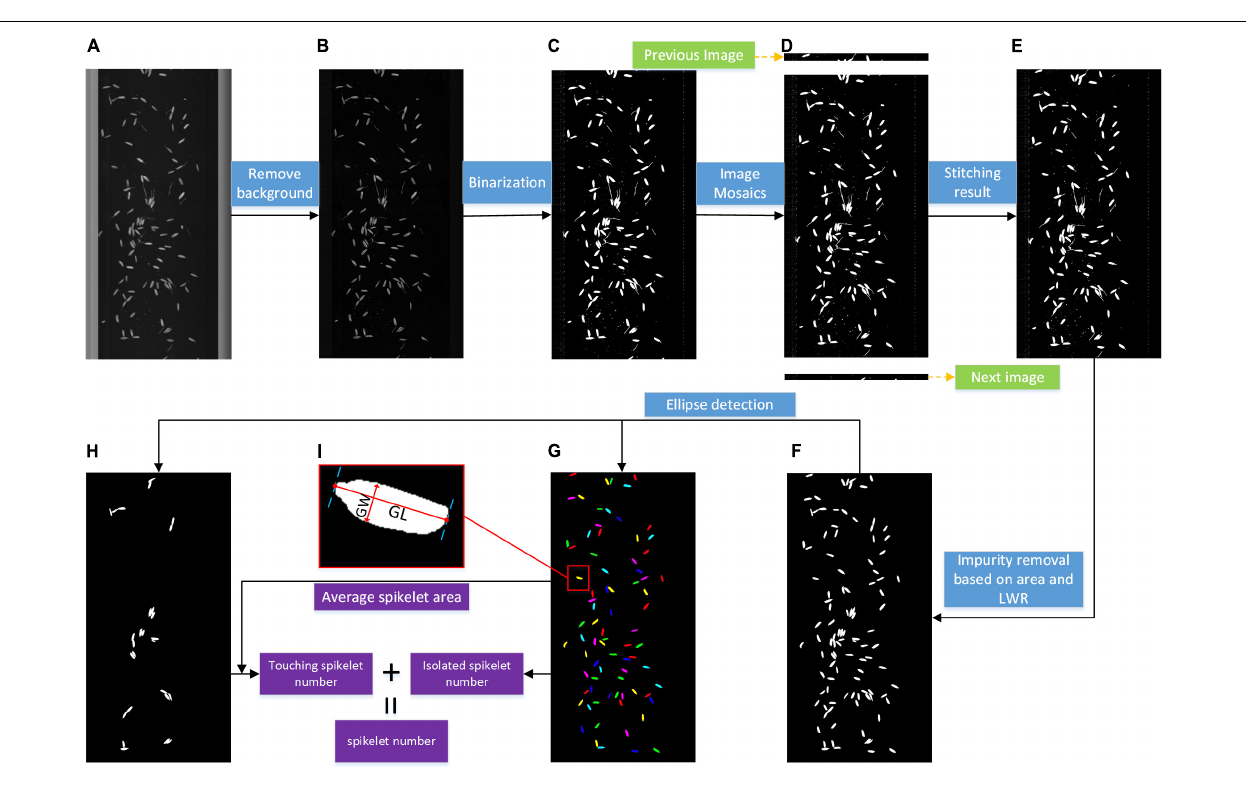
FIGURE 4 | Pipeline for the grain image